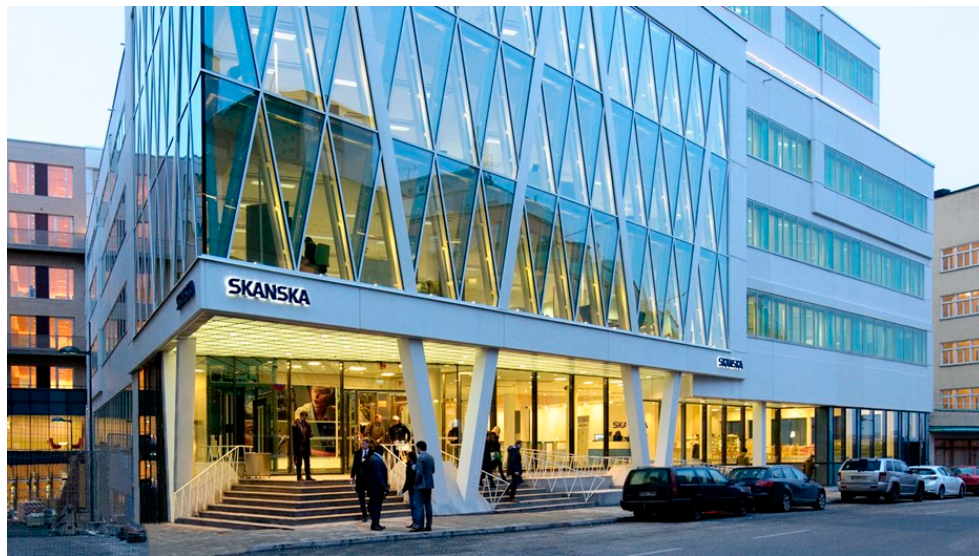
Figure 1. Entrance of the office building [27].